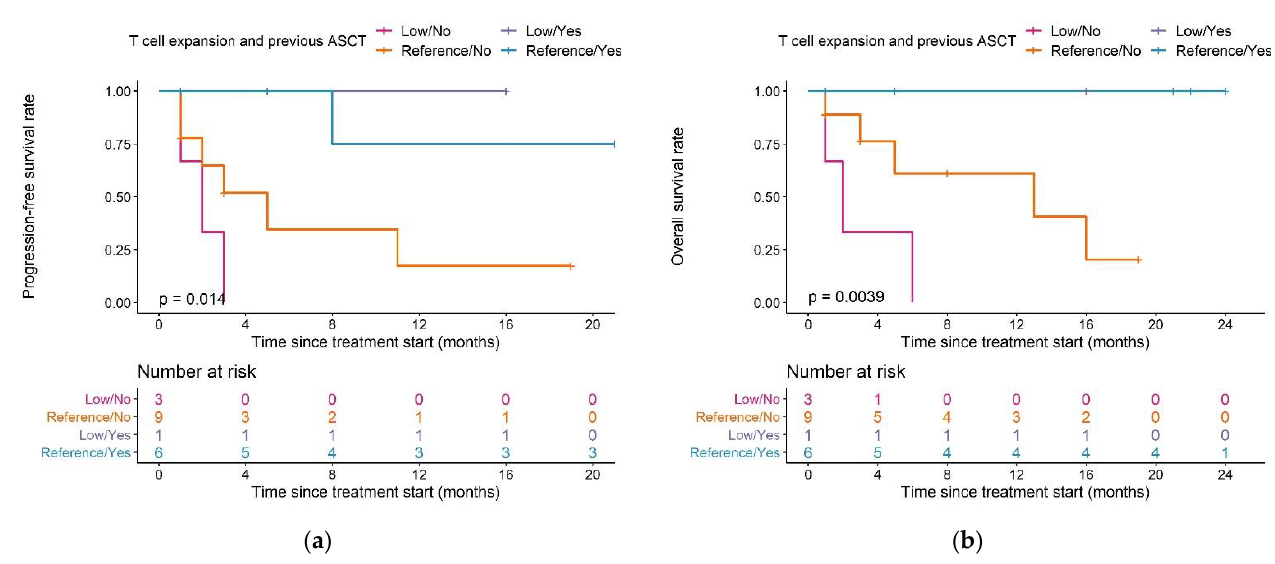
Figure 8. Kaplan–Meier plots for ( a ) progression-free survival and ( b ) overall survival in patients with different combinations